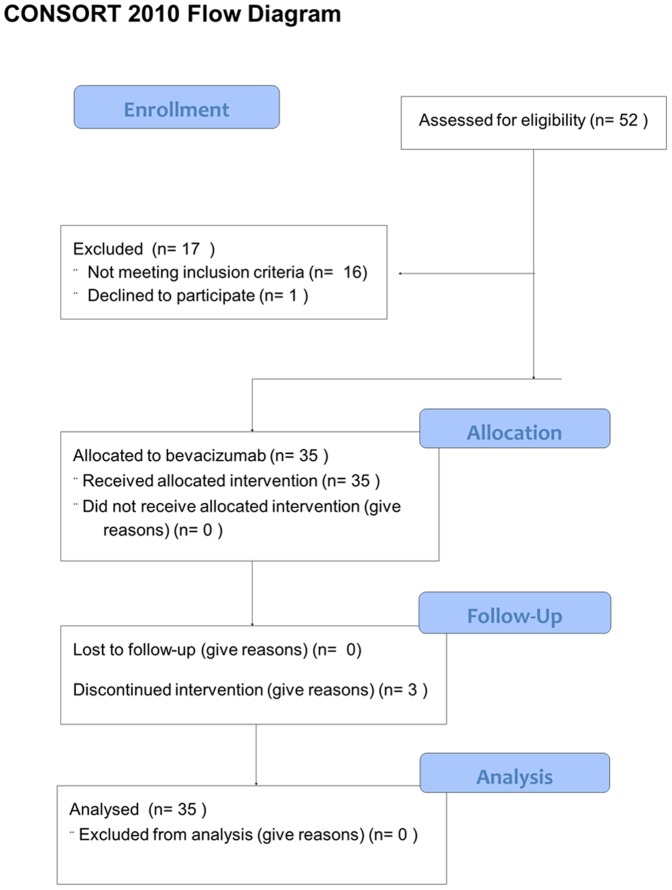
Study flow diagram.Between April 2005 and August 2009, 52 patients with metastatic melanoma were screened. Thirty-five of those patients were eligible according to inclusion criteria and received the study drug.